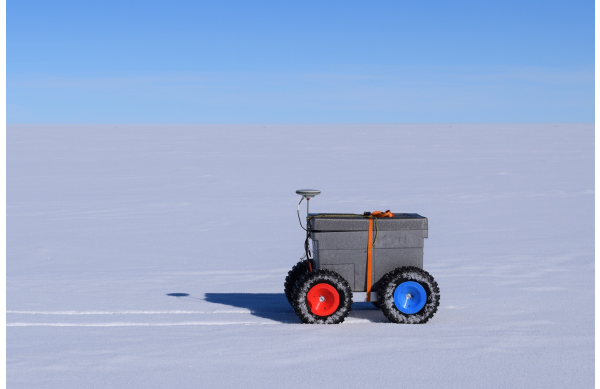
Figure 2. Photograph of the CIC rover taken on 4 July 2017 during its first mission out of the EastGRIP camp. The rover was able to pull three cargo boxes and a person, a weight of nearly 170kg, in a low-friction plastic sled in untouched snow. This weight is more than twice that of common commercial ground-penetrating radar systems, which could be towed behind the rover to map accumula- tion